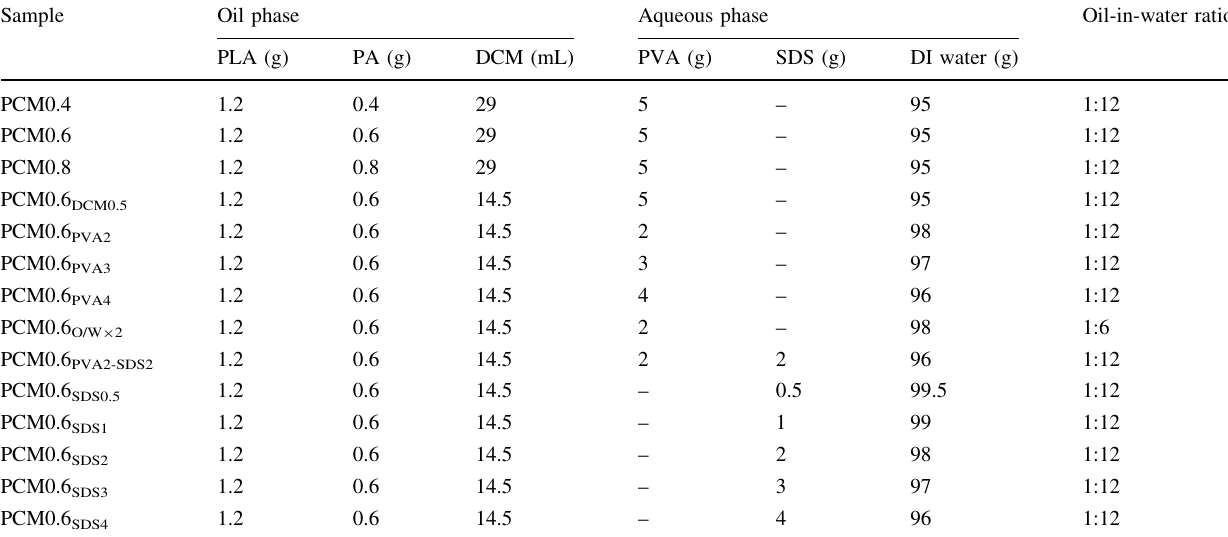
Table 1 Conditions for the preparation of PLA–PA microPCM